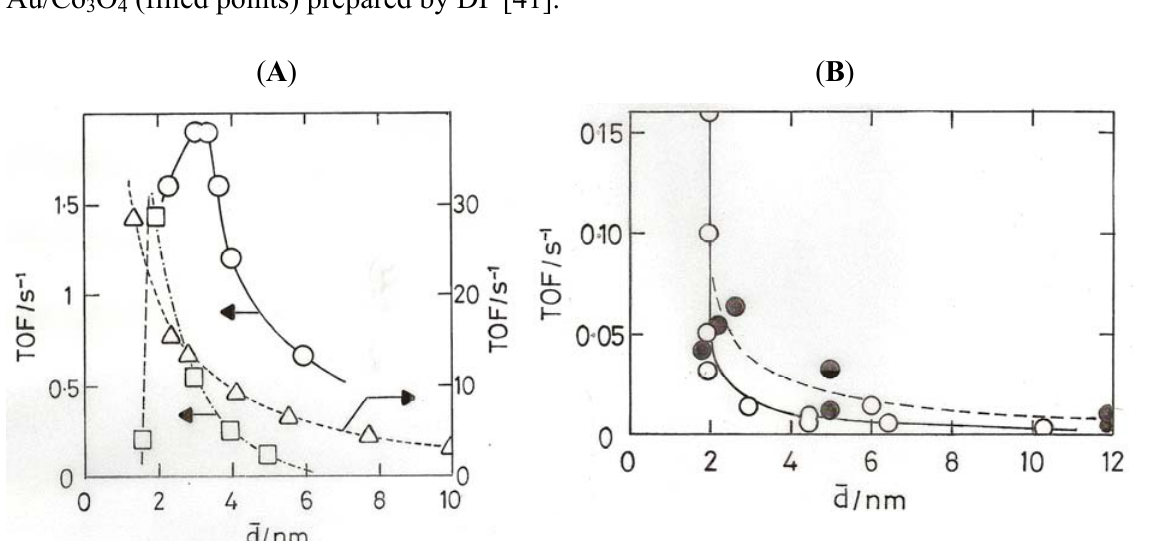
(110) at 473 K [37]. 2 (open points) and Au/Fe 2